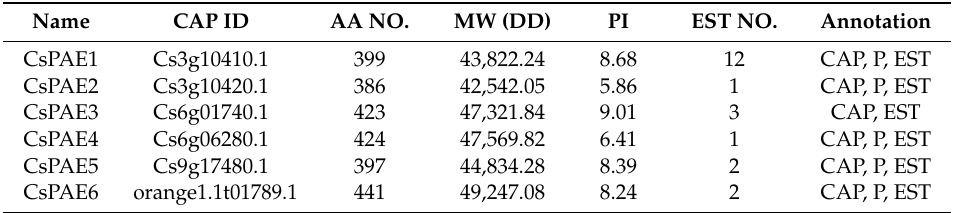
Table 1. List and details of PAEs identified in C. sinensis